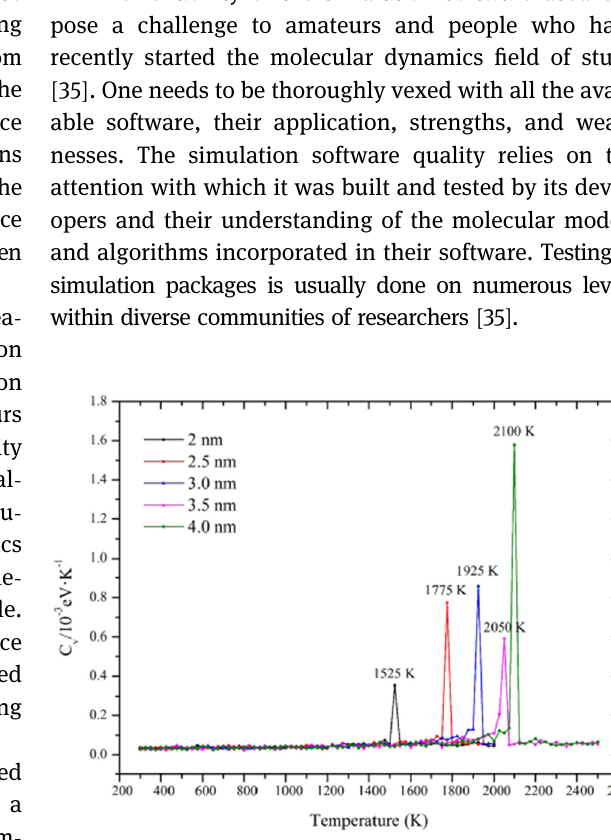
Figure 21: Heat capacity values ( C v ) of various size FNPs [ 161 ]